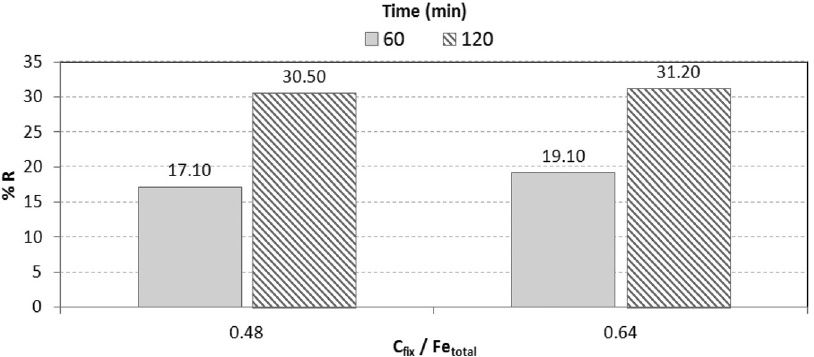
Figure 3: The reduction (%) as a function of the reduction time and the ratio of C fix /Fe total